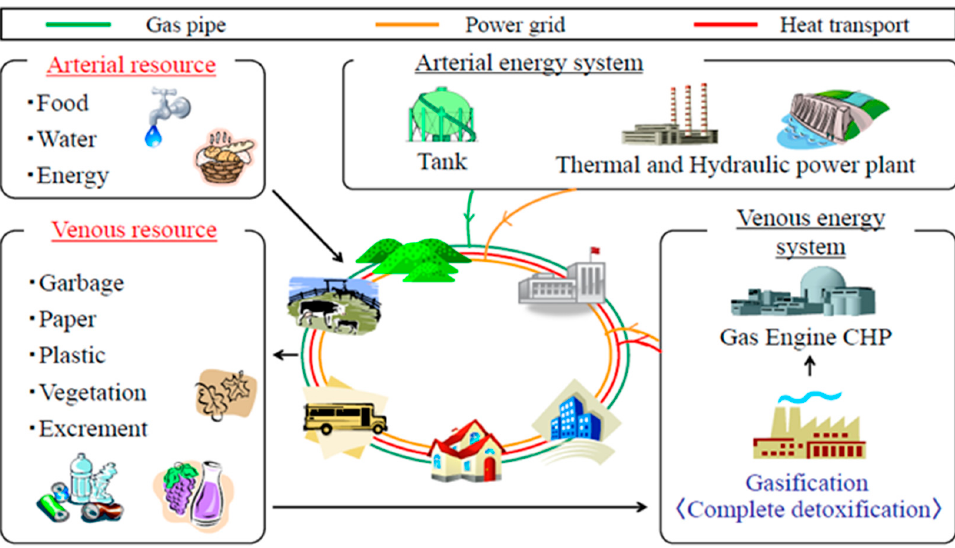
Figure 1. Holonic approach to a city energy generation system [8].